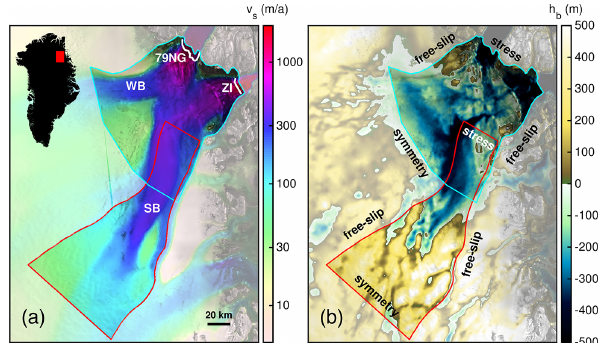
Figure 2. Overview of the NEGIS region and modelling domain. (a) Observed surface velocities (Joughin et al., 2016, 2018). (b) Bed topography (Morlighem et al., 2017). The red and cyan lines in (a) and (b) delineate the ice-stream and outlet modelling domains, re- spectively. White lines in (a) indicate flux gate locations at 79NG and ZI (see Fig. 9 and related text below). WB and SB indicate the western and southern branches of the NEGIS. Symmetry, free-slip and stress in (b) indicate the boundary condition types used as lat- eral margins. Background image is a RADARSAT Mosaic (Joughin, 2015; Joughin et al.,